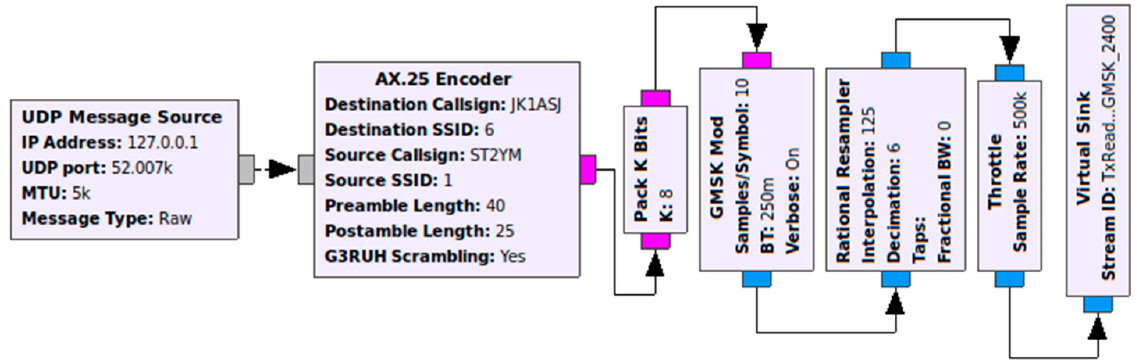
Figure 7. Data input block.